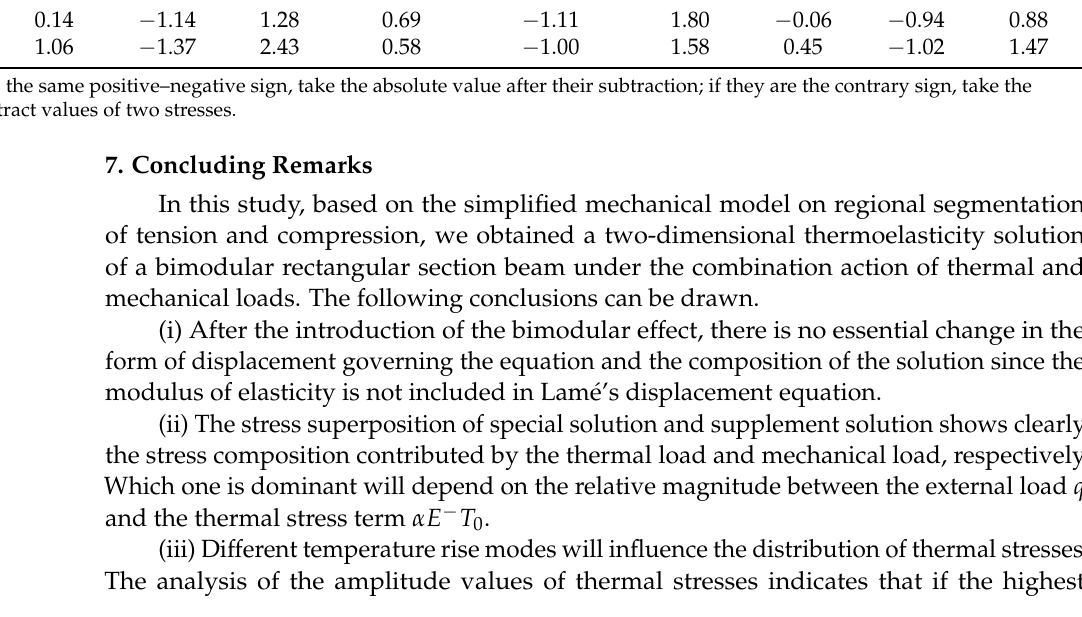
Table 2. Dimensionless thermal stresses and amplitude values.